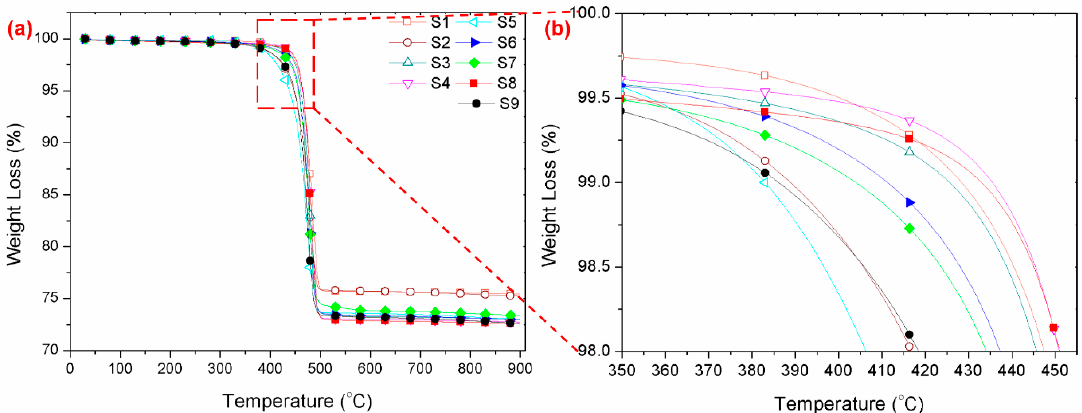
Figure 3. ( a ) Thermal degradation behaviour of polypropylene/milled carbon fibre/exfoliated graphene nano-platelets/synthetic graphite (PP/MCF/xGNP/SG) composite at different compression moulding parameters ( b ) Enlargement of Figure 3(a).